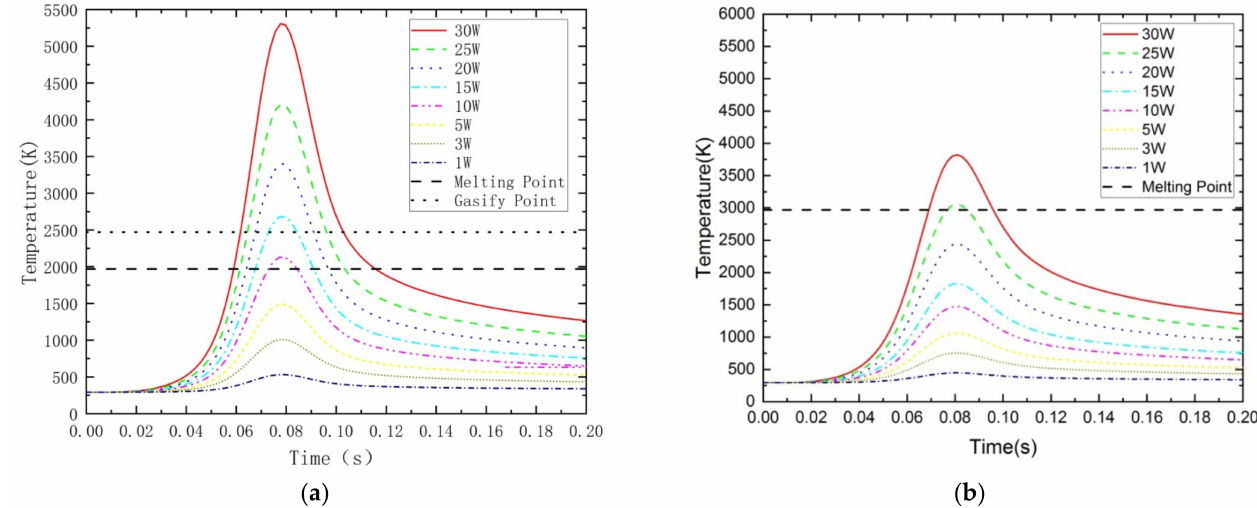
Figure 6. Heat transfer temperature curve of silicon carbide under different power values. ( a ) Surface impurities (silica, silicon) have a scanning speed of 1500 mm/s under different power temperature curve of point A. ( b ) Temperature curve of point